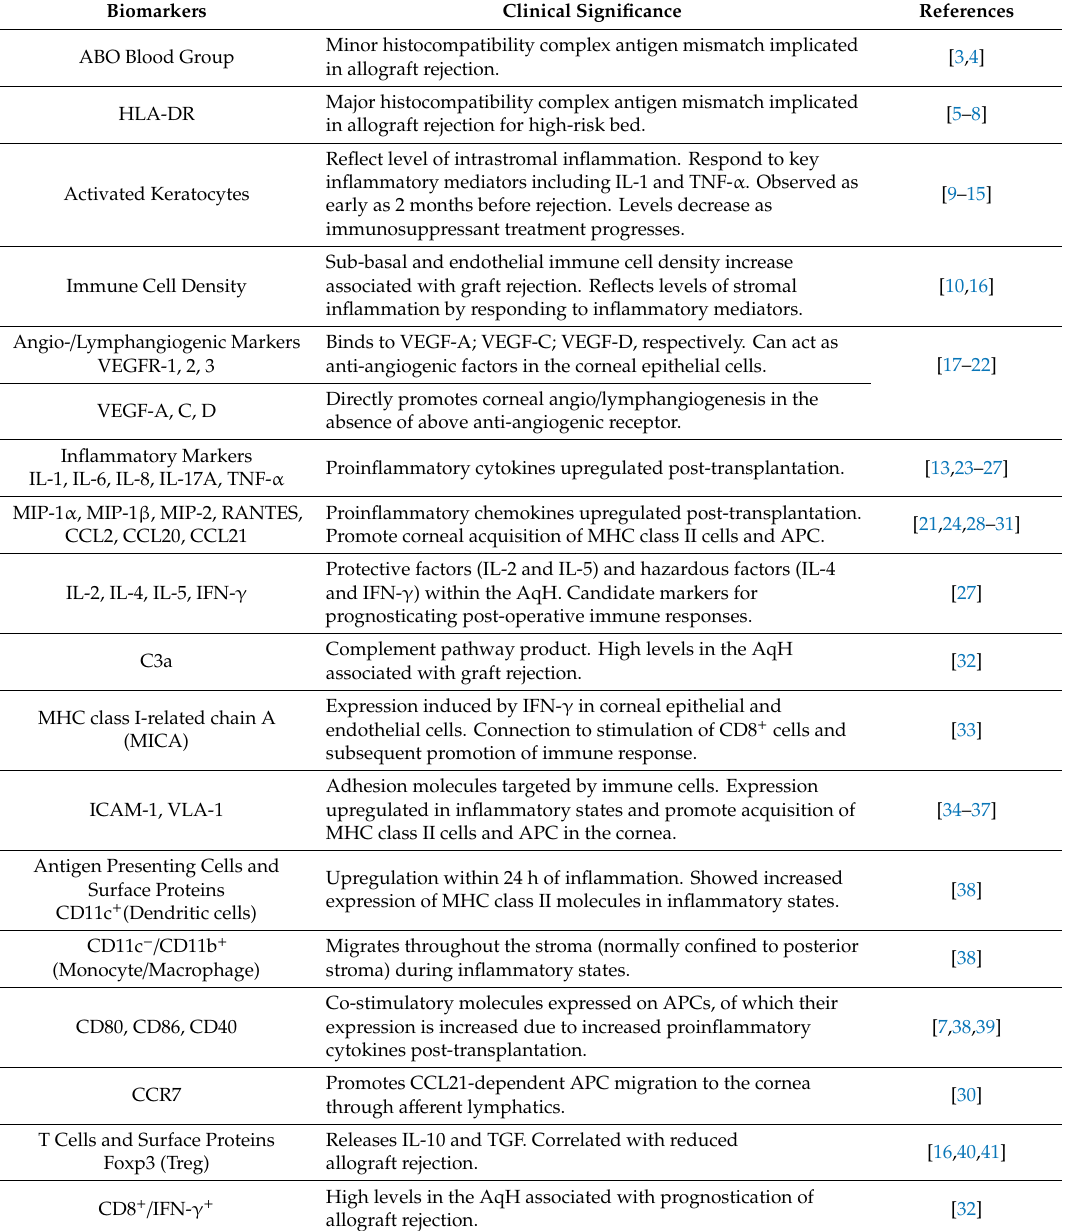
Table 1. Candidate biomarkers for detection and prediction of corneal allograft rejection.